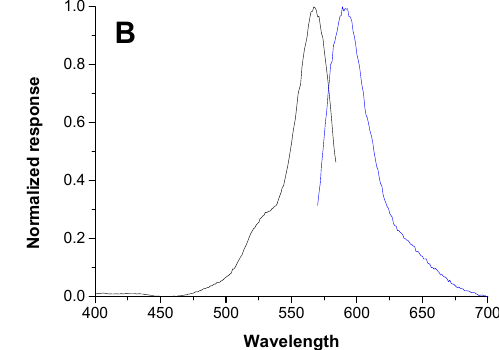
Figure 3. Normalized excitation (black line) and emission (blue line) spectra of 10 –5 M trypsin probe ( A ) and 10 –6 M chy- motrypsin probe ( B ) in Tris-HCl buffer (pH = 8.0) measured at 37 °C. 3.3. Solid Supports for On-Resin Enzymatic Cleavage As the core of this study was enzyme detection in an on-resin manner, the establish- ment of the appropriate matrix predestined for enzymatic cleavage in aqueous solution was an important task. To compare the suitability of different resins, the trypsin probe